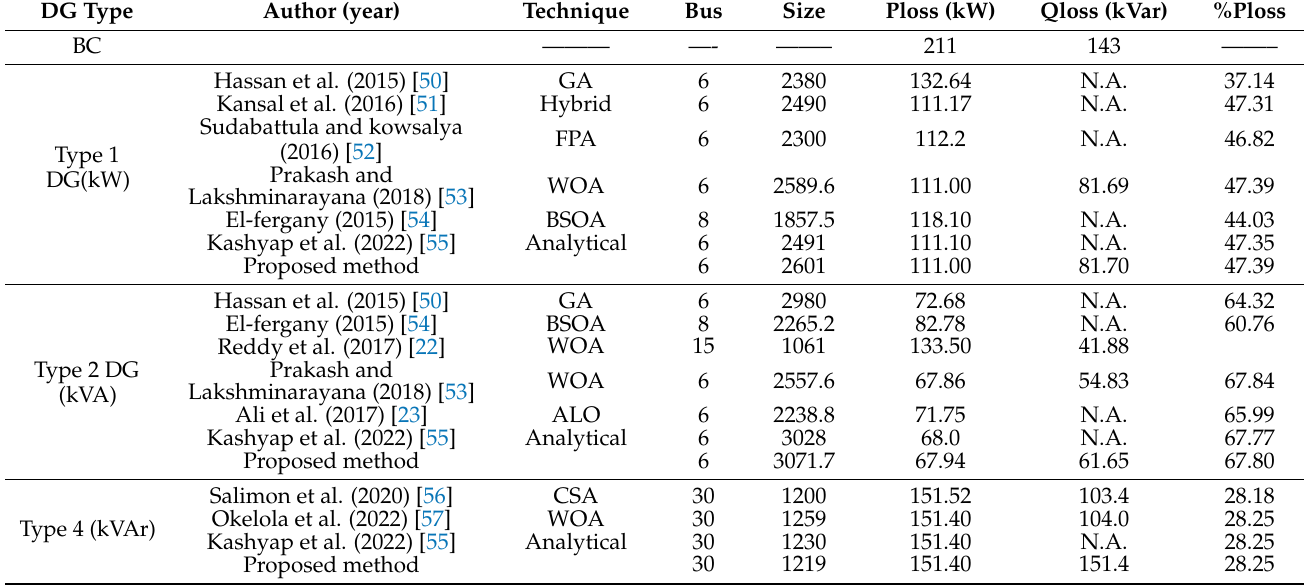
Table 7. Comparative Study for the optimal results for the 33-bus